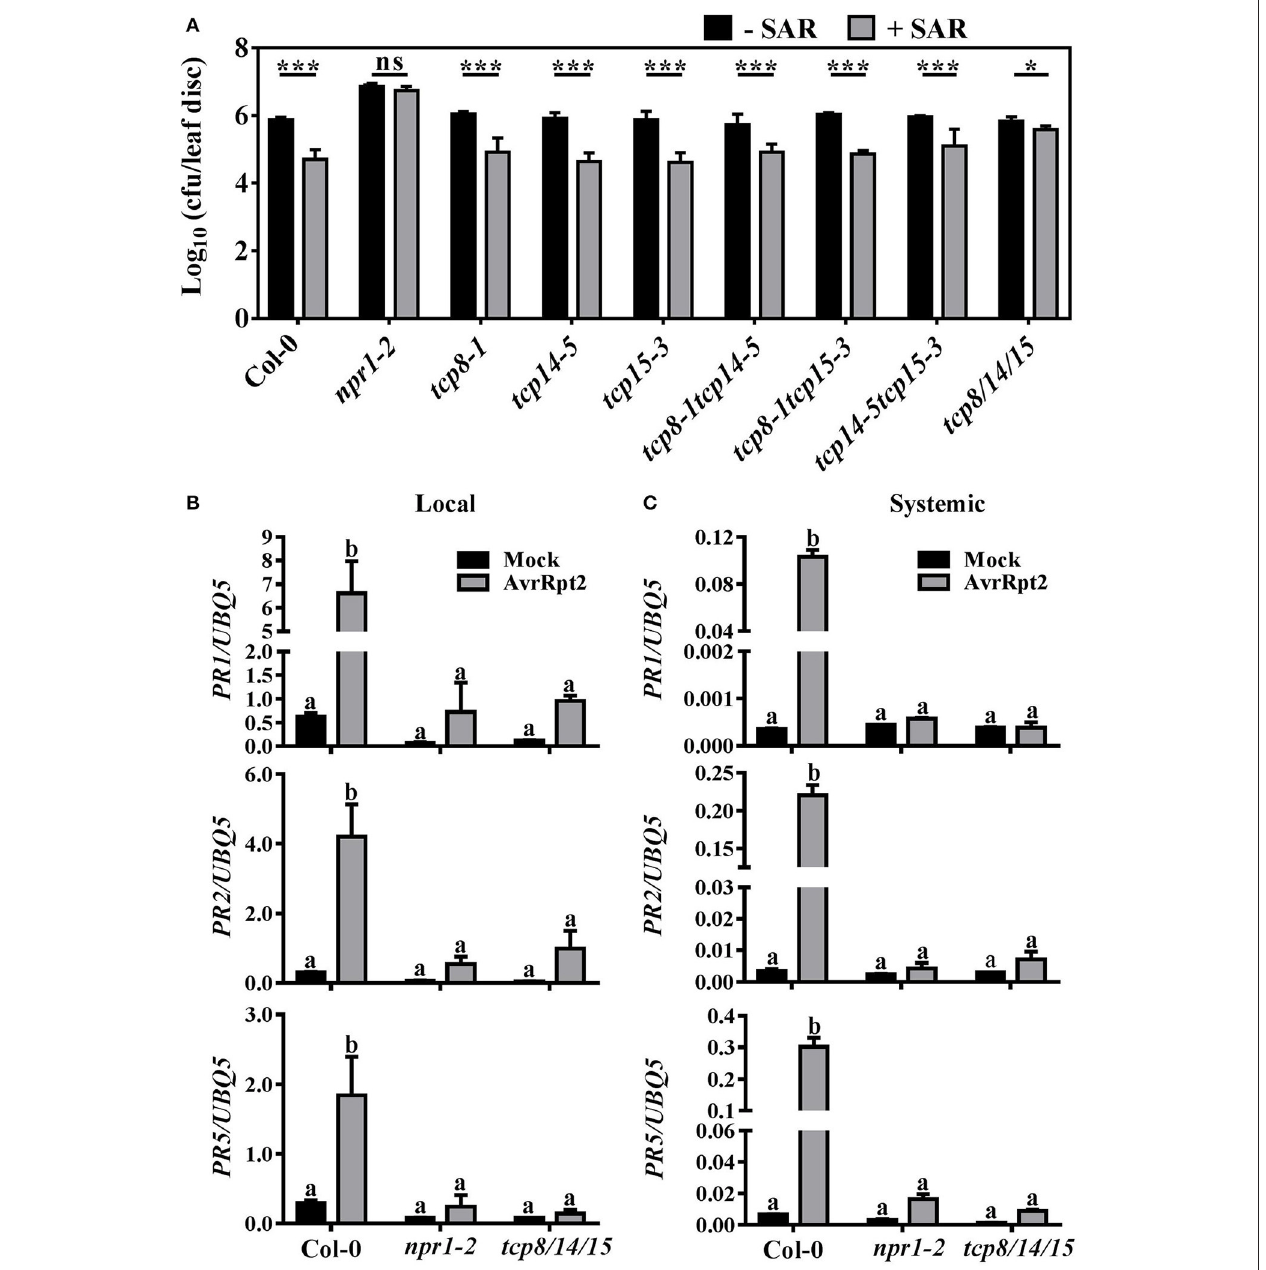
FIGURE 2 | TCP8, TCP14, and TCP15 contribute redundantly to SAR establishment. (A) Bacterial population in Col-0, npr1-2 , and the tcp mutants. Two lower leaves of 3-week-old plants were infiltrated with 10mM MgCl 2 (-SAR) or Pseudomonas syringae pv. maculicola ( Psm ) ES4326 carrying avrRpt2 at OD 600 = 0.02 ( + SAR). Three days later, two upper leaves were infiltrated with Psm ES4326 at OD 600 = 0.001. Bacterial growth in infected systemic leaves was calculated 3 days after the second infection. Error bars represent SD of six biological repeats. Statistical analysis was studied by t -test (* p < 0.05, *** p < 0.001) using Excel 2016. (B,C) The expression of PR1 , PR2 , and PR5 in Col-0, npr1-2 , and tcp8/14/15 . Two local leaves were inoculated with 10mM MgCl 2 (Mock) or Psm ES4326 with avrRpt2 at OD 600 = 0.02 (AvrRpt2). The mRNA levels of PR1 , PR2 , and PR5 in local leaves at 12h post inoculation (hpi) (B) and in systemic leaves at 48 hpi (C) were analyzed by RT-qPCR. Values were normalized to the UBQ5 mRNA levels. Error bars represent SD of three biological repeats. Statistical analysis was studied by two-way ANOVA following multiple comparisons with turkey test (95% confidence interval) using GraphPad Prism 7. Different small letters above the bars mean significant differences.